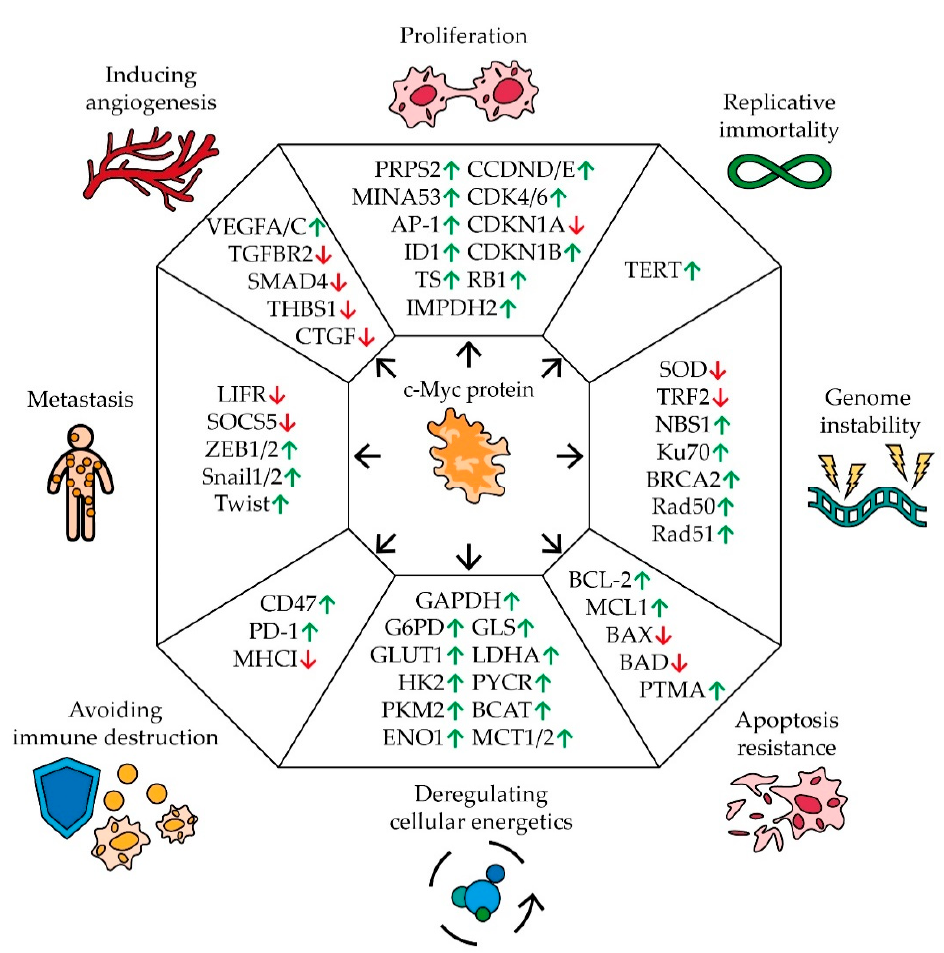
Figure 1. The impact of MYC proto-oncogene on the hallmarks of cancer development. Schematic representation of c-Myc’s effect on pivotal genes involved in carcinogenic pathways. Arrows indicate an increase (green) or a decrease (red) in gene expression in response to MYC expression (see text for description and references).